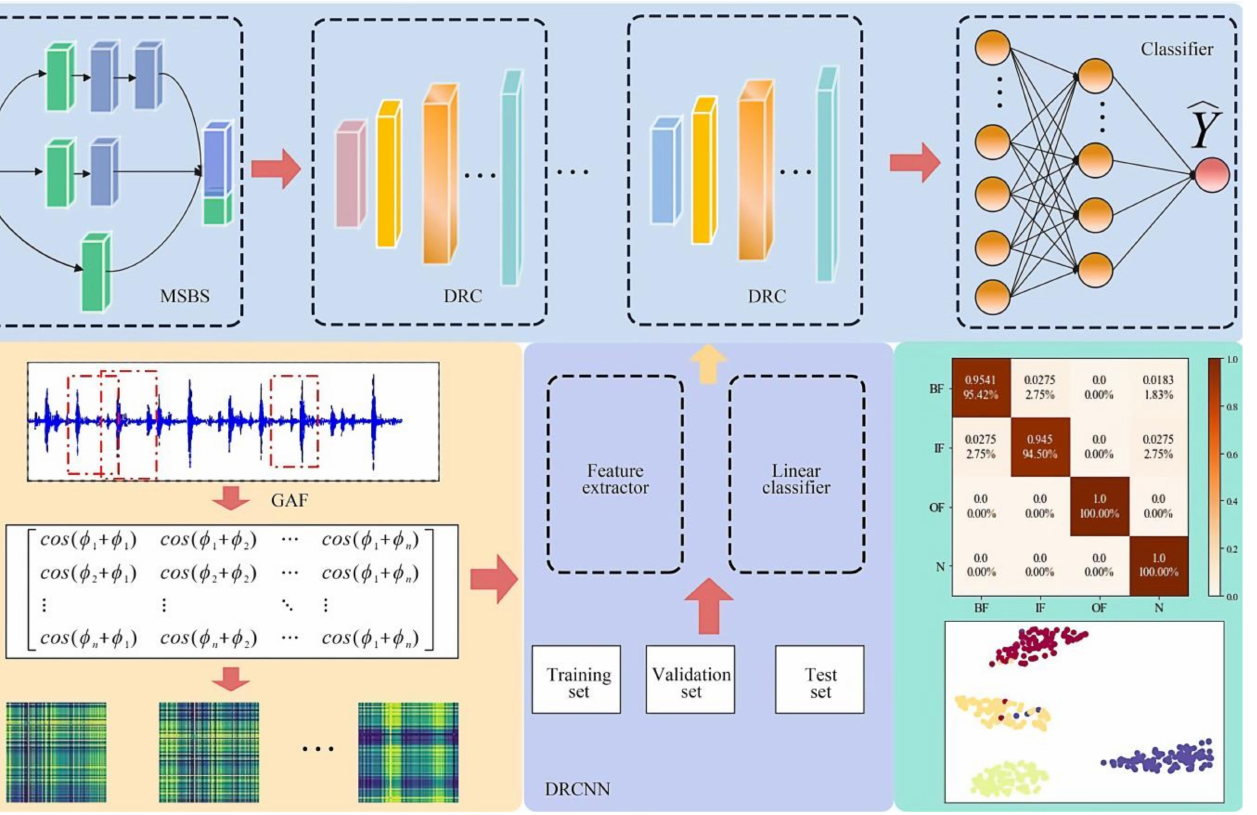
Figure 8. Diagnosis